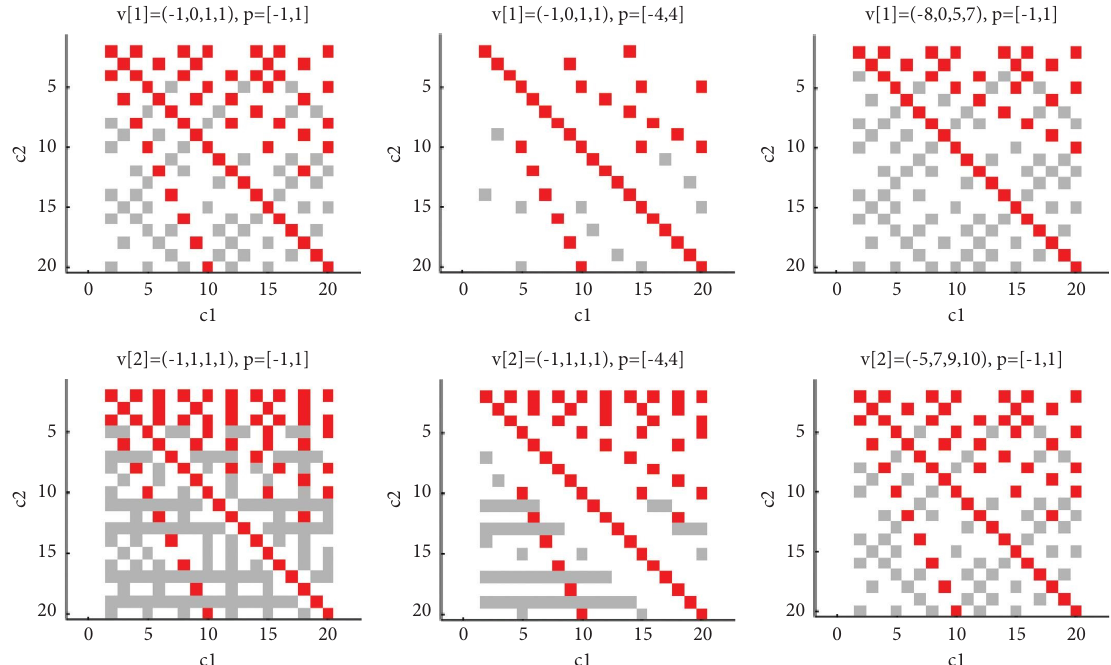
Figure 5: Attractors for tuples v at the same time (here, global attractors are again those with c be an integer multiple of c